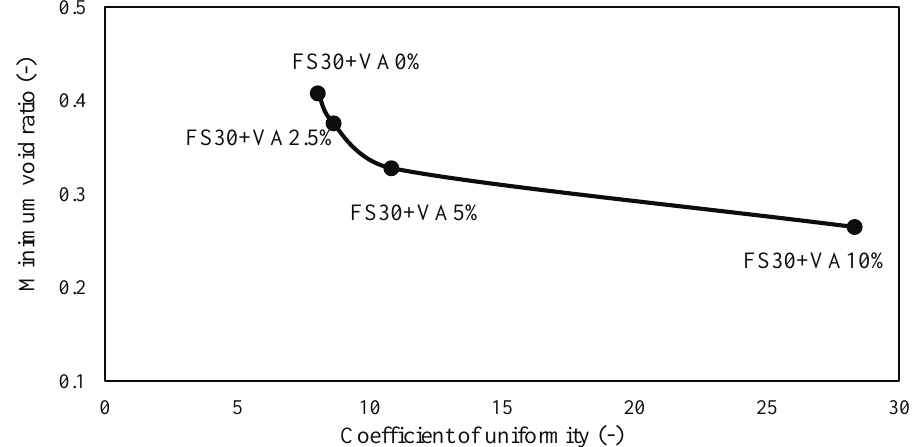
Figure 2. Modified Proctor compaction test results of FS30 and different amounts of binder (0, 2.5, 5, 10%).